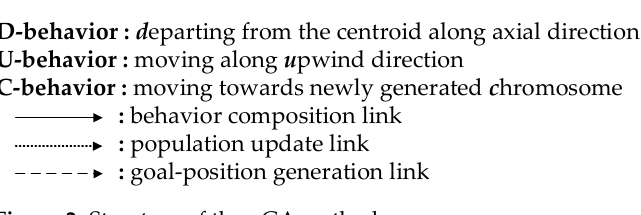
Figure 2. Structure of the uGA method.